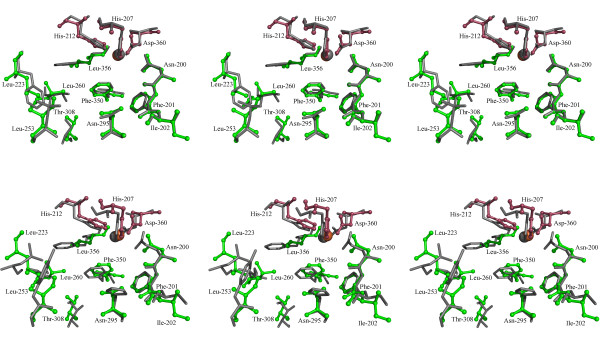
Comparison of biphenyl 2,3-dioxygenase active site to other Rieske oxygenaes. Comparison of the active sites of NDO-O9816-4 and BPDO-ORHA1 with BPDO-OB1. NDO-O9816-4 (top) and BPDO-ORHA1 (bottom) active site residues are shown as smooth grey lines and the active site iron is shown as a grey sphere. BPDO-OB1 is aligned and overlaid in each of the images. Residues that coordinate the mononuclear iron are shown as red ball and stick models, while residues that form the active site pocket are shown as green ball and stick models. The mononuclear iron for BPDO-OB1 is shown as a rust colored sphere. Residues are labeled using numbering from BPDO-OB1. Left and center images are wall-eyed stereo, center and right images are cross-eyed stereo.